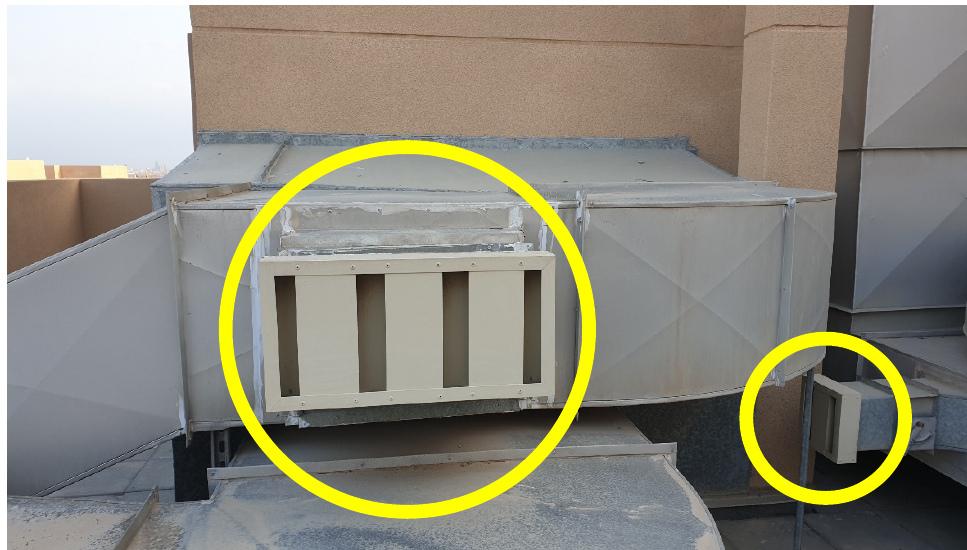
Figure 9. HVAC outdoor air inlets. (shown within circles)